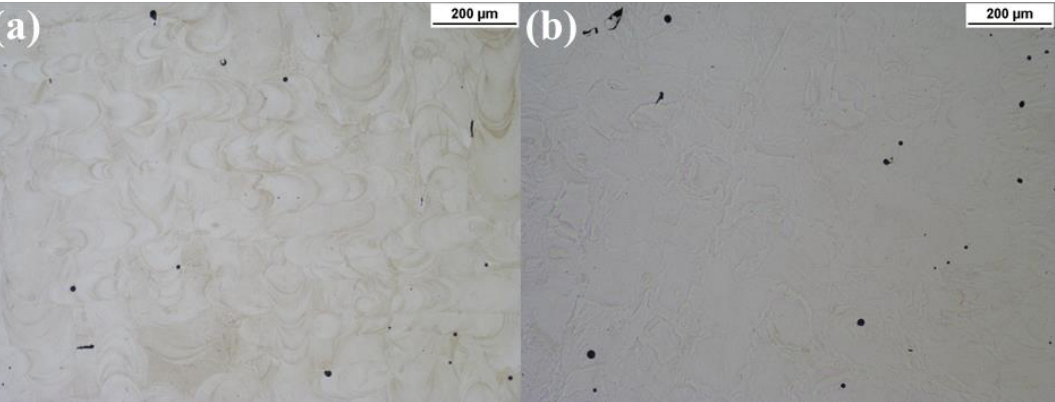
Figure 13. Substrate microstructure in ( a ) as-coated condition and ( b ) heat-treated condition.